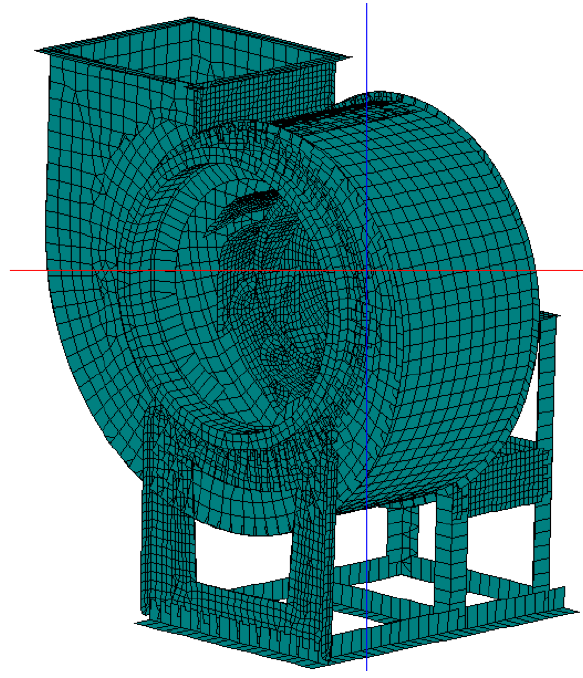
Figure 1. Model of the ventilator